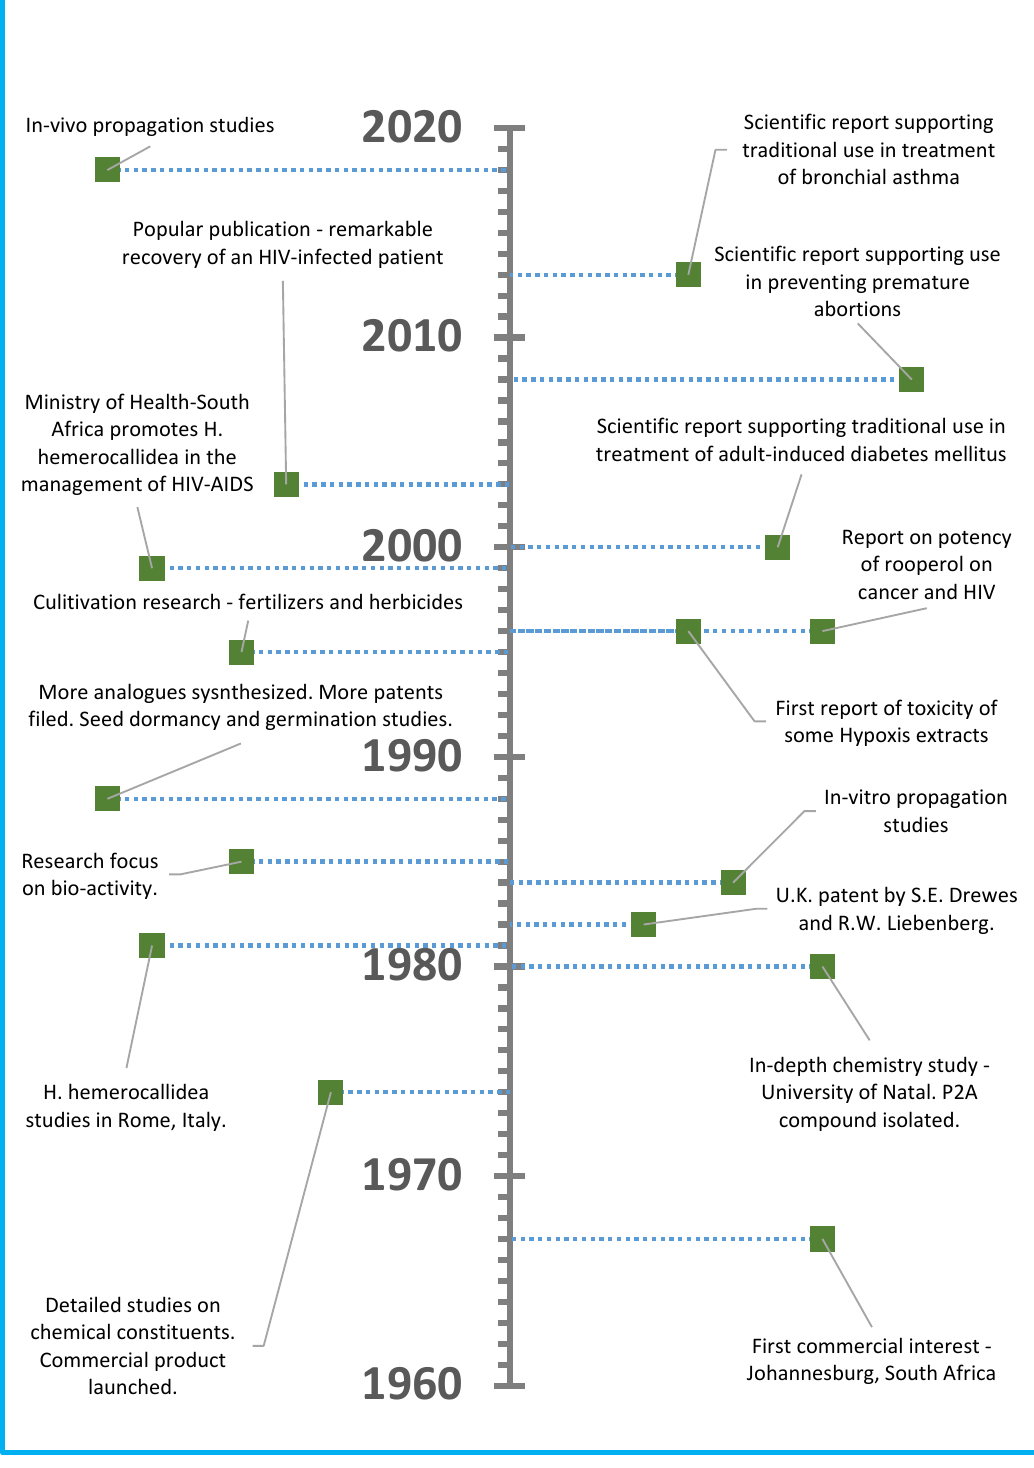
Figure 2. The timeline (1960–2020) of research and commercial use of Hypoxis hemerocallidea .